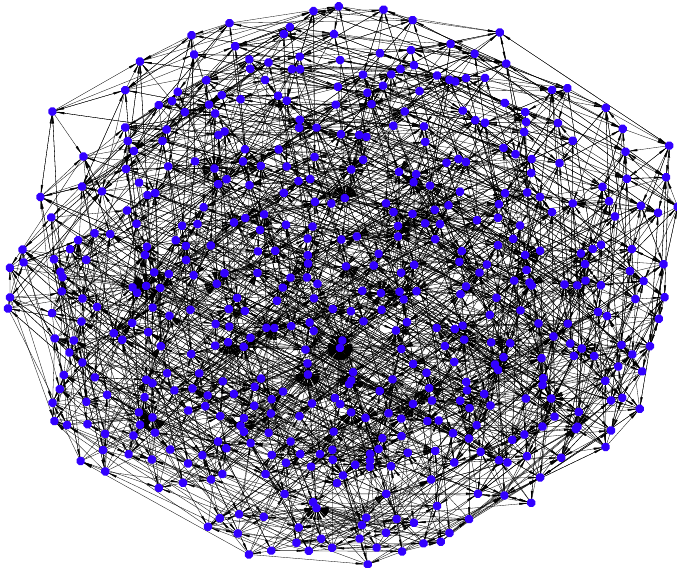
Figure A1. STG of the reference scenario. Graph nodes and edges represent ecosystem states and transitions, respectively. This STG consists of 482 states and 2640 transitions. Nodes color is